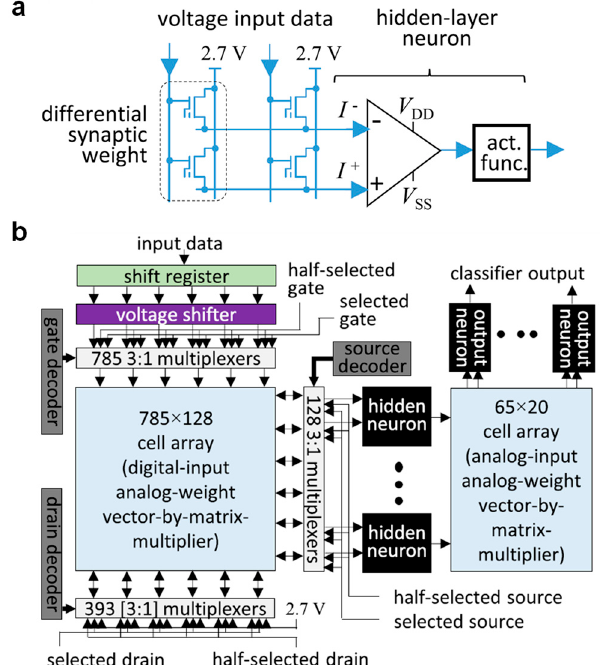
Figure 8. ( a ) Differential implementation of a synaptic connection followed by a hidden ‐ layer neuron, consisting of a differential summing operational amplifier and an activation ‐ function block. ( b ) High ‐ level architecture of the artificial neural network and needed additional circuitry. Reprinted with permission from [55]. Copyright 2018, IEEE.